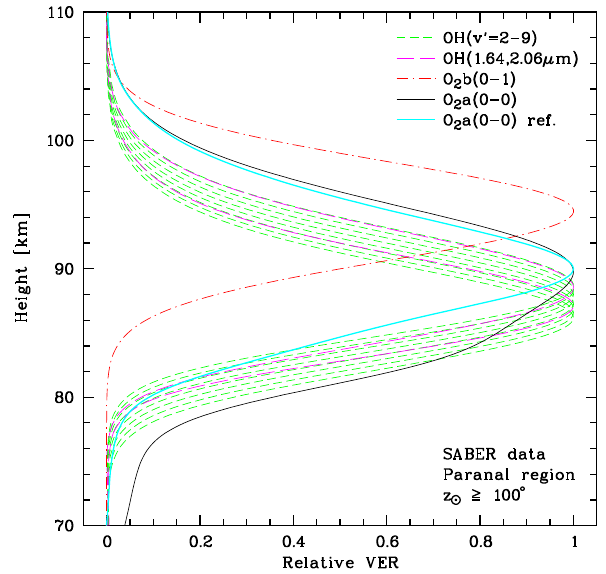
Figure 9. O 2 a (0-0) VER profiles scaled to the emission peak for the Cerro Paranal SABER sample. Mean profiles for five different noc- turnal local time (LT) periods are shown (see legend). For compar- ison, the O 2 a (0-0)-based reference profile is also displayed (light solid